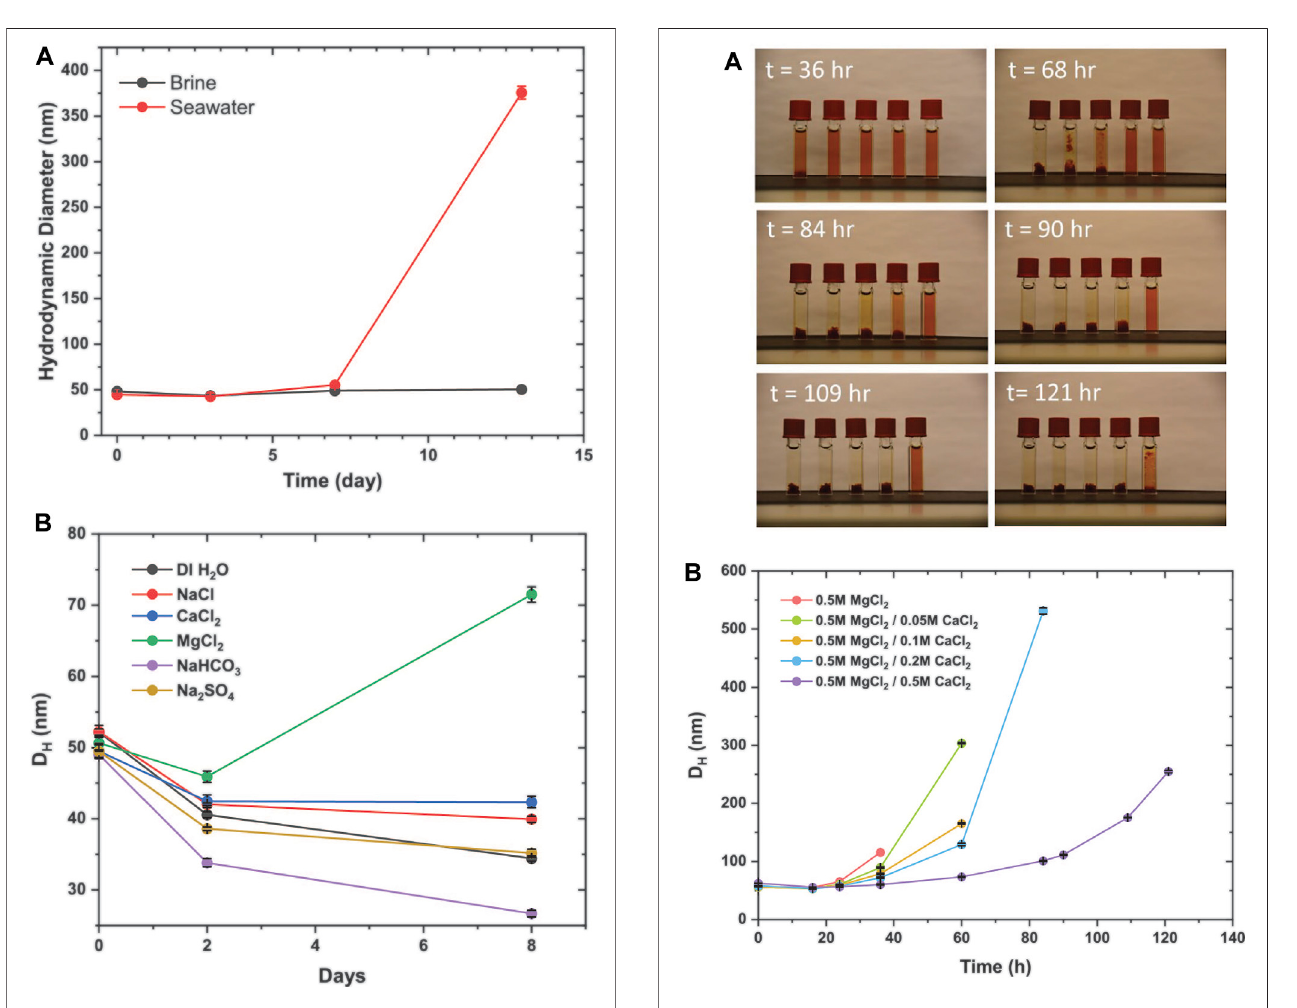
FIGURE 2 | (A) DLS graphs of the average hydrodynamic diameter of Dex-SPIONS in seawater (left) and brine (right) versus elapsed time at 103 ° C. (B) Average hydrodynamic diameters of dextran-coated nanoparticles as a function of heating at 103 ° C in various electrolyte solutions for the speci fi ed time intervals. NaCl = 700 mM; CaCl 2 = 16 mM; MgCl 2 = 87 mM; NaHCO 3 = 2 mM; Na 2 SO 4 = 45 mM.